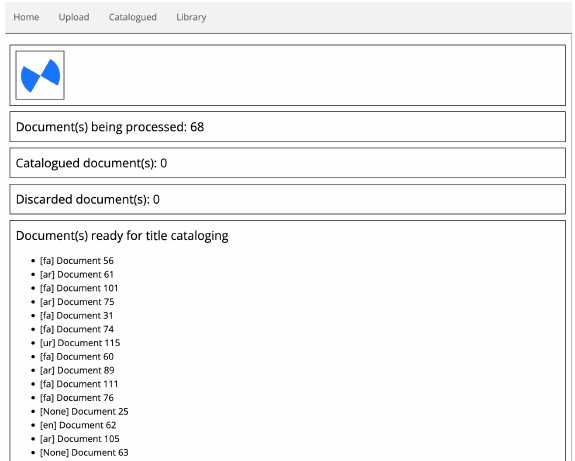
Figure 5. Preliminary resulting cataloguing tool prototype UI: Document preprocessing.